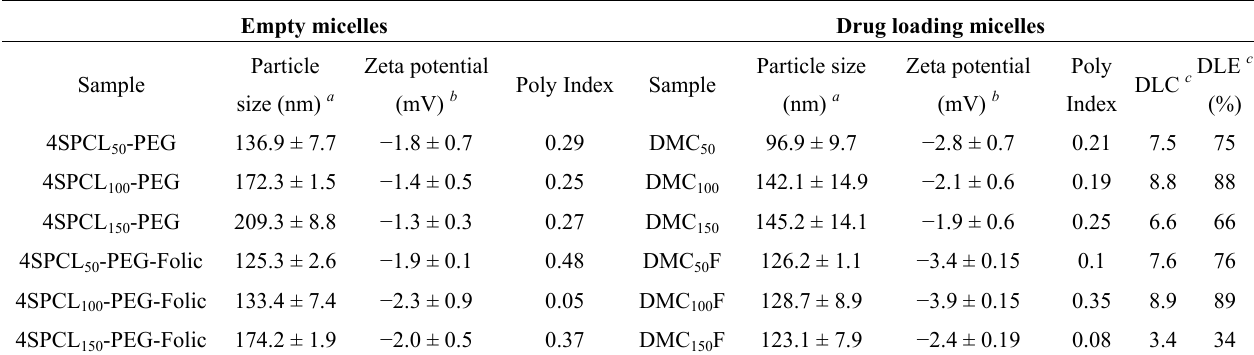
Table 2. The properties of doxorubicin (DOX)-loaded star-shaped micelle. Empty micelles Drug loading